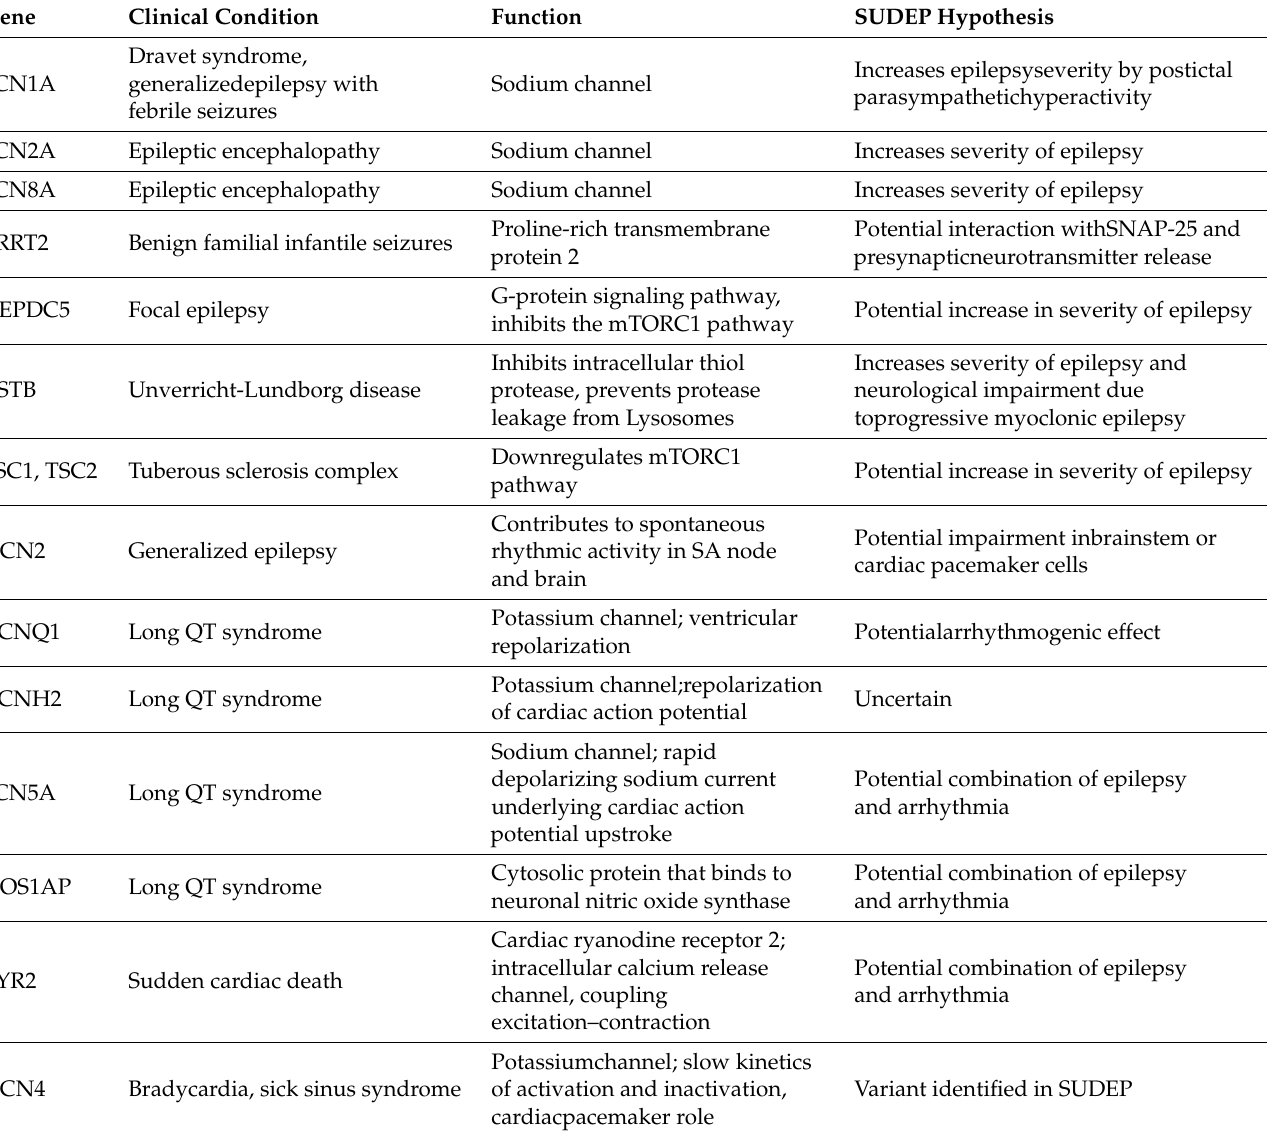
Table 1. Genetic association with